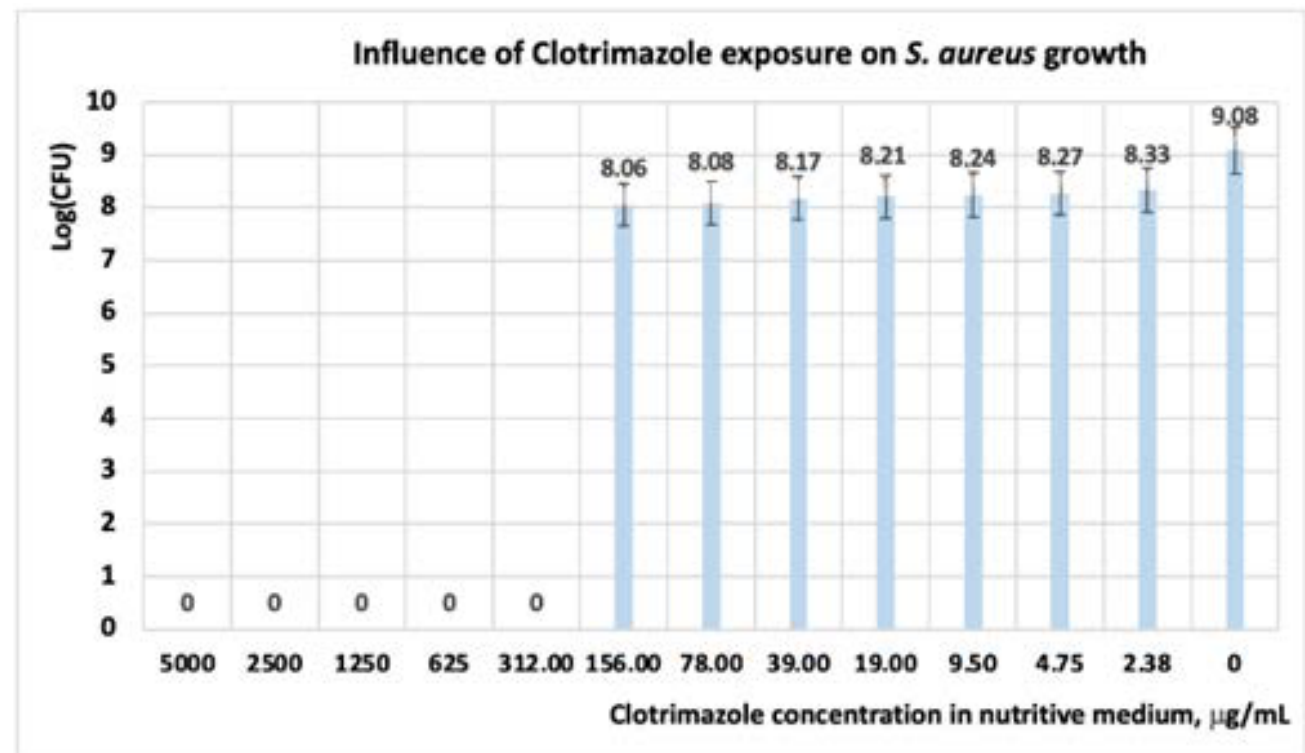
Figure 3. Influence of CT exposure on S. aureus growth, after 24 h. At a concentration of clotrimazole in the culture medium higher than 156 μg/mL, S. aureus is inhibited.